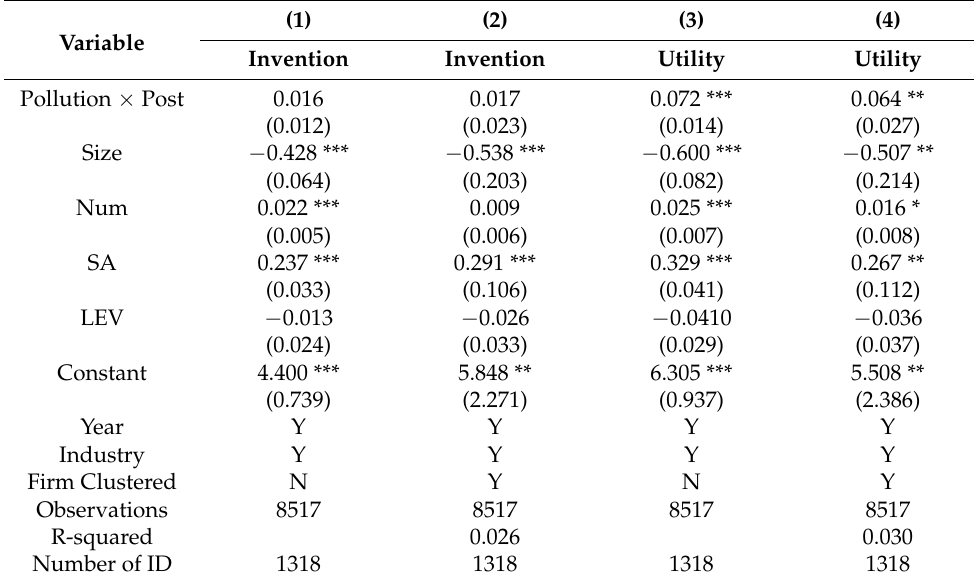
Table 9. Analysis of heterogeneity of green patent types.